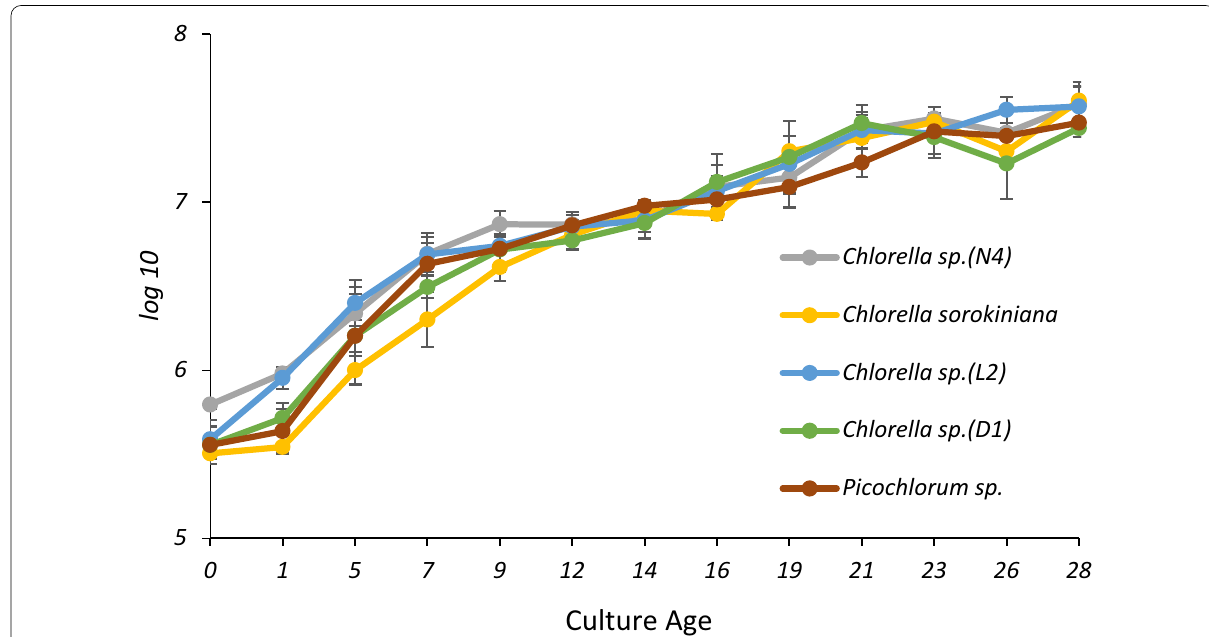
Fig. 1 Comparison of cell density growth profile from different algal strains grown in BBM